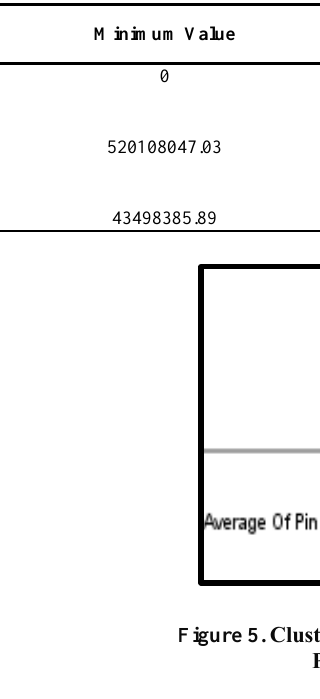
Figure 4. Clusters of variable of “Average Amount of ATM Transactions”. Table 4. Results of clustering on Average Pin Pad transactions.